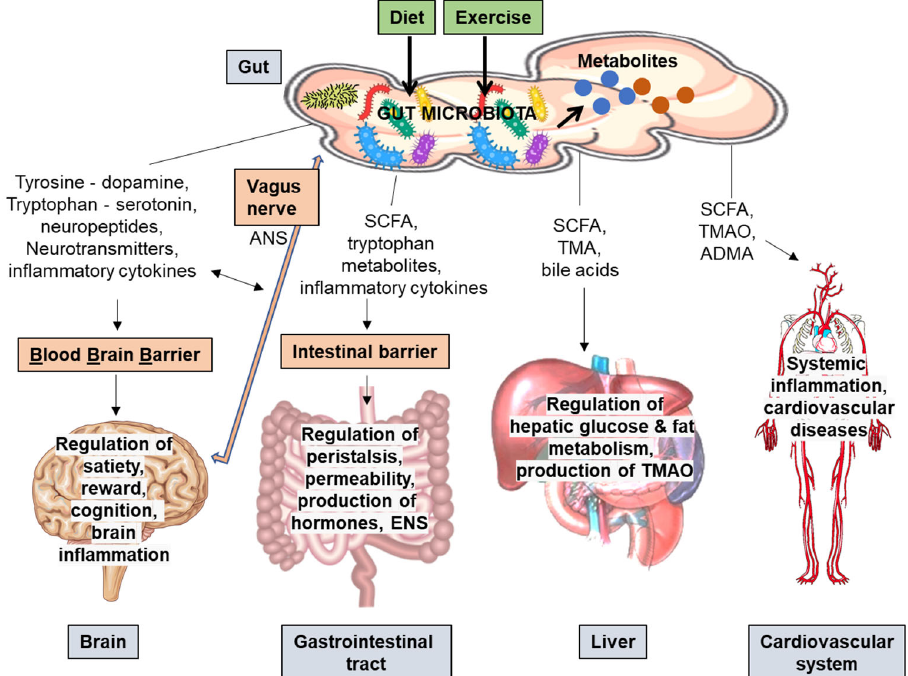
Figure 1. Examples of the metabolites produced by the gut microbiota (GM), and some effects of these metabolites on the bodily functions of the host. Diet and exercise are known to modulate the composition, species richness and diversity of the GM, which further leads to alterations in the production of the microbial metabolites. For example, the GM affect the metabolism of tyrosine and tryptophan that are precursors of dopamine and serotonin, respectively. Within the gut, for instance, dopamine affects the innate immune system and serotonin plays a critical role in regulating gut peristalsis. However, these gut-derived classical neurotransmitters can also have direct effects on the brain. The possible pathways include direct signaling via enteric nervous system (ENS), autonomic nervous system (ANS) and the vagus nerve, or via aryl hydrocarbon receptor ‐ mediated pathway, or via still unknown pathways. Additionally, the GM can alter the production of several other neurotransmitters and neuropeptides. In the brain, these regulate, e.g., satiety, reward, and cognition. The GM produce short ‐ chain fatty acids (SCFA) from the dietary fiber, for instance. These metabolites can regulate various functions in the gastrointestinal tract and affect the ENS. The SCFA can penetrate through blood brain barrier (BBB) into the brain, and have direct effects on, e.g., stimulating brain neurotrophic factors, diminishing inflammation and enhancing satiety. The SCFA together with bile acids regulate glucose and fat metabolism favorably in the liver. However, the metabolites can also be health risk factors for disease conditions. The GM ‐ produced trimethyl amine is further converted to trimethylamineoxidase (TMAO) in the liver. TMAO has been associated with cardiovascular diseases. In addition to TMAO, the GM ‐ produced asymmetric dimethylarginine (ADMA) is associated with cardiovascular disease outcomes under a broad range of circumstances. Higher serum ADMA may be a result of excessively metabolized proteins by the GM. In general, the GM play a critical role in regulating the innate systems, and several metabolites produced by the GM can either directly increase or decrease host inflammation. For instance, the production of SCFA can importantly reduce systemic inflammation, which improves the integrity of the gut epithelia and BBB. Abbreviations: ADMA, asymmetric dimethylarginine; ANS, autonomic nervous system; BBB, blood brain barrier; ENS, enteric nervous system; GM, gut microbiota; SCFA, short ‐ chain fatty acids; TMA, trimethyl amine; TMAO, trimethylamineoxidase.